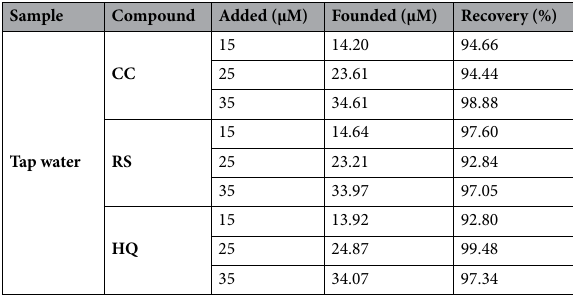
Table 2. Recoveries of CC, RS and HQ in a local tap water sample at poly(CBBG)/MCPE.